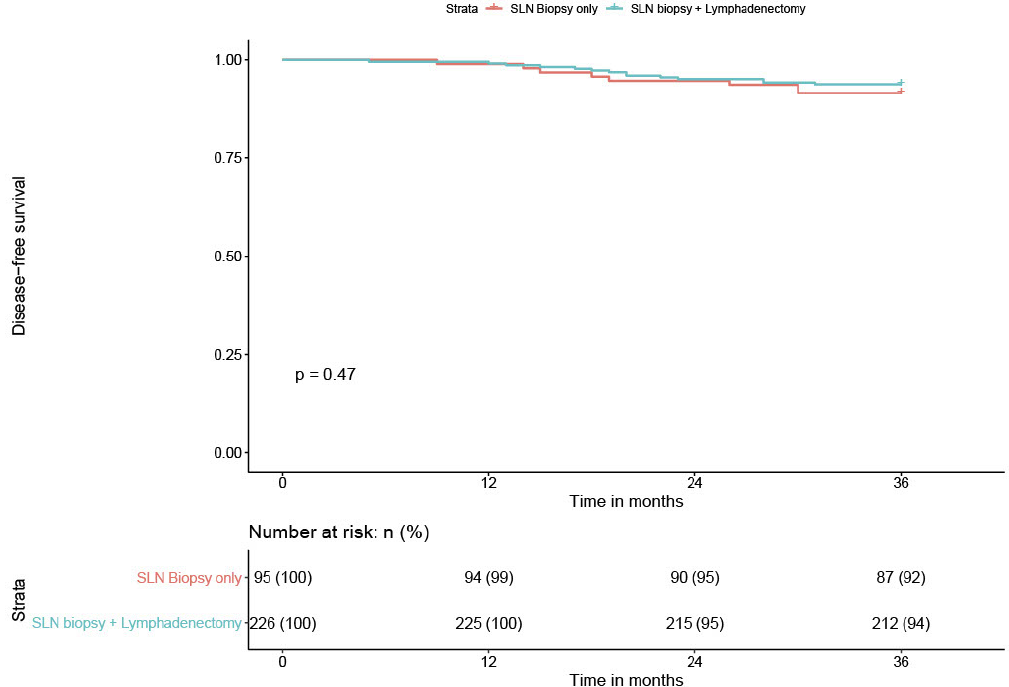
Figure 6. DFS of low-volume metastasis patients according to the type of nodal staging. SLN = sentinel lymph node.